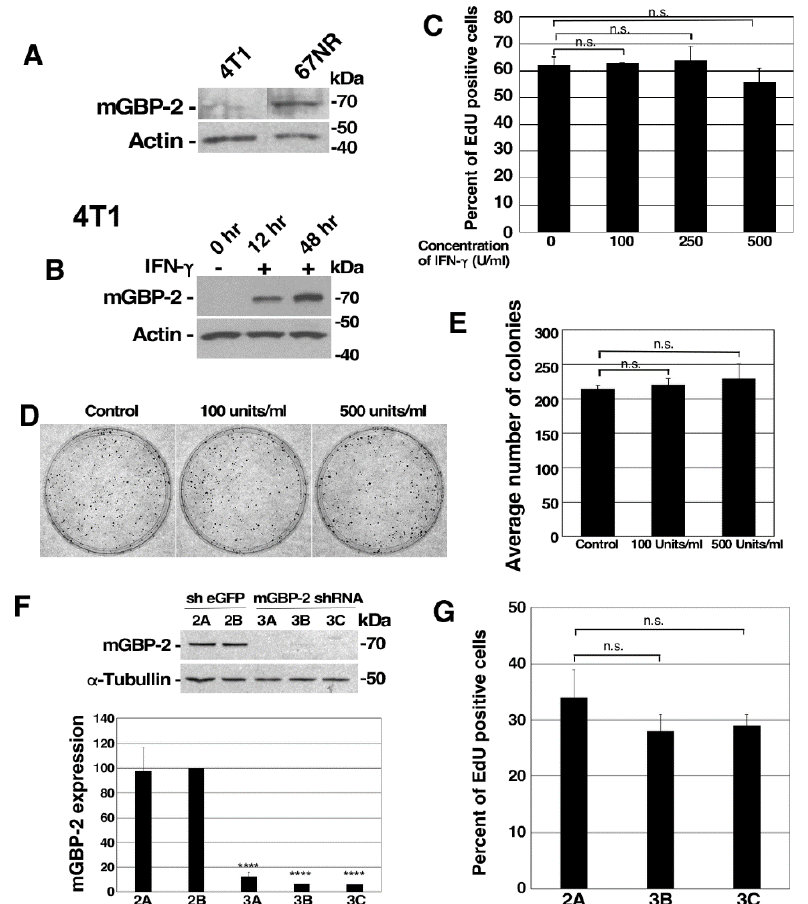
Figure 2. mGBP-2 expression inversely correlates with migration and proliferation in murine TNBC cell lines. ( A ) Lysates from 4T1 and 67NR cells (20 μ g) were analyzed for mGBP-2 and actin by western immunoblot (WB). A representative blot is shown ( n = 3). mGBP-2 does not inhibit 4T1 or 67NR cell proliferation. ( B ) 4T1 cells (1 × 10 6 ) were treated with 100 U/mL IFN- γ for the times indi- cated. Cells lysates (20 μ g) were analyzed for mGBP-2 and actin by WB. A representative blot is shown ( n = 3). ( C ) 4T1 cells (1.5 X 10 4 cells/coverslip) were treated with IFN- γ (0, 100, 250, and 500 U/mL). After 72 hrs, Click-it chemistry was performed as described in Materials and Methods. The graph depicts the average percentage of EdU positive cells ± SD ( p = 0.7165, n = 3). ( D ) 4T1 cells (1 × 103 cells/dish) were treated with IFN- γ for 96 hrs. Cells were stained with crystal violet. Representa- tive photomicrographs are shown. ( E ) All of the colonies with 50 or more cells were counted per plate and represented as average number of colonies per condition + SD ( p = 0.3559, n = 2). ( F ) Lysates (20 μ g) from 67NR cells expressing mGBP-2 shRNA (3A, 3B, and 3C) or control shRNA (sheGFP 2A and 2B) were analyzed for mGBP-2 and α -tubulin by WB. A representative gel is shown ( n = 3). Data was analyzed as described and the ratio of mGBP-2 and α -tubulin densitometric values were repre- sented as the average mGBP-2 expression ± S.D relative to control shRNA (shEGFP 2B) (****, p < 0.0001, n = 3). ( G ) 67NR cells containing sh eGFP 2A and two clones of mGBP-2 shRNA 3 (mGBP-2 shRNA 3B and mGBP-2 shRNA 3C) (3 × 10 5 cells/coverslip) were cultured in duplicates in 6-well dishes analyzed for EdU incorporation as described. The graph depicts the average percentage of EdU positive cells ± SD ( p = 0.0741, n = 3). n.s.= not signficant. 3.3. mGBP-2 Does Not Alter 4T1 or 67NR Cell Proliferation The increased wound healing observed with 4T1 cells could reflect either increased migration, increased proliferation, or a combination of both. GBPs are well documented to alter cell proliferation both in vitro and in vivo [4,5,13,15,18,27 – 29]. In fact, the expression of hGBP-1 in murine breast cancer cells inhibits their proliferation both in vitro and in vivo [5]. The proliferation of 4T1 and 67NR cells were examined by EdU incorporation (Sup- plementary Figure S1B). 4T1 cells incorporated EdU into about 60% of the cells within 1